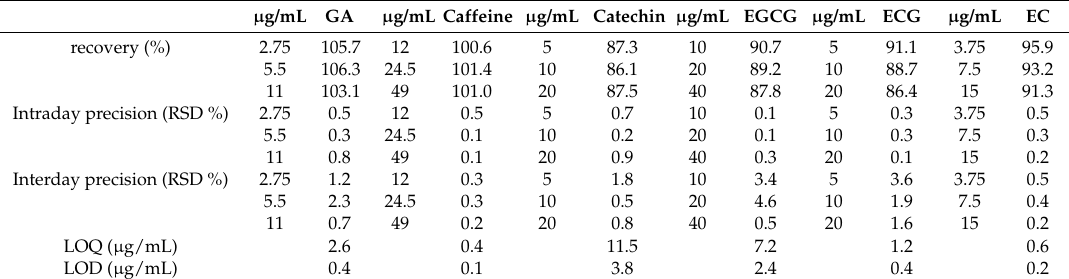
Table 4. Accuracy (recovery %), intraday precision (RSD %), interday precision (RSD %), limit of quantification (LOQ) and limit of detection (LOD) of the analytical method, suitable for the quantification of GA, caffeine, catechin, EGCG, ECG and EC in tea samples. The concentration ( µ g/mL) of each analyte added to tea samples is reported.